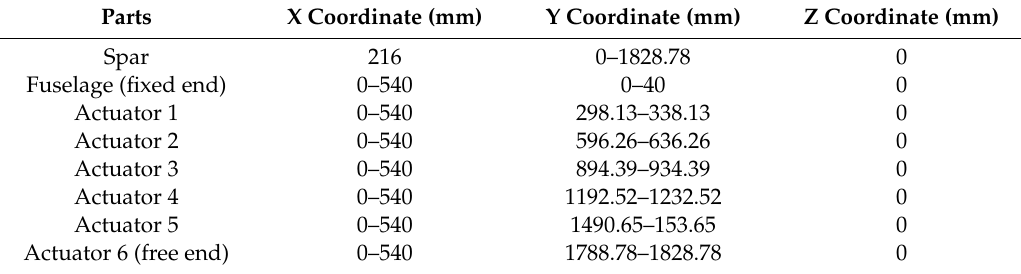
Table 2. Wing boundary conditions and their perspective